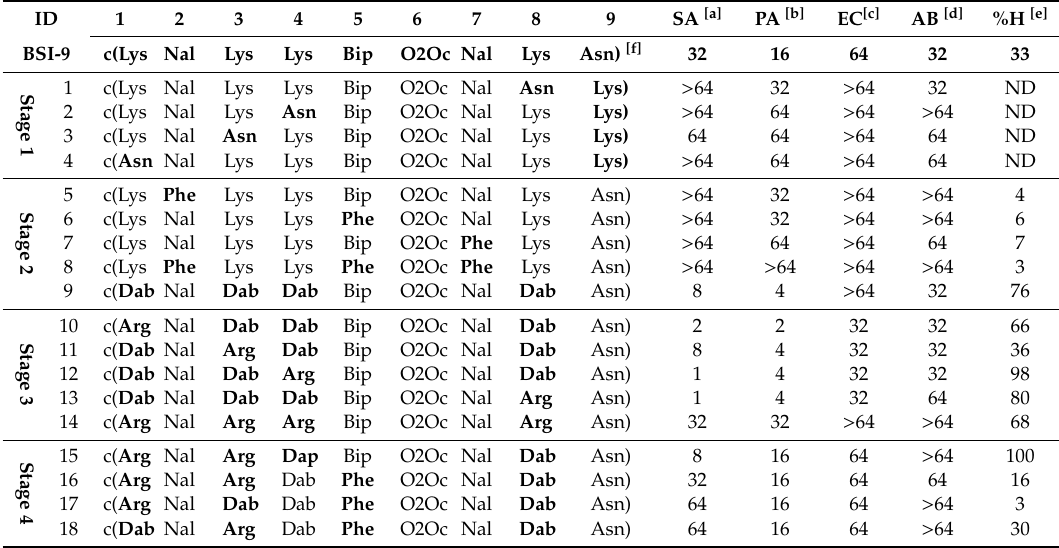
Table 1. Minimum inhibitory concentration ( µ g / mL) and percent hemolytic activity against red blood